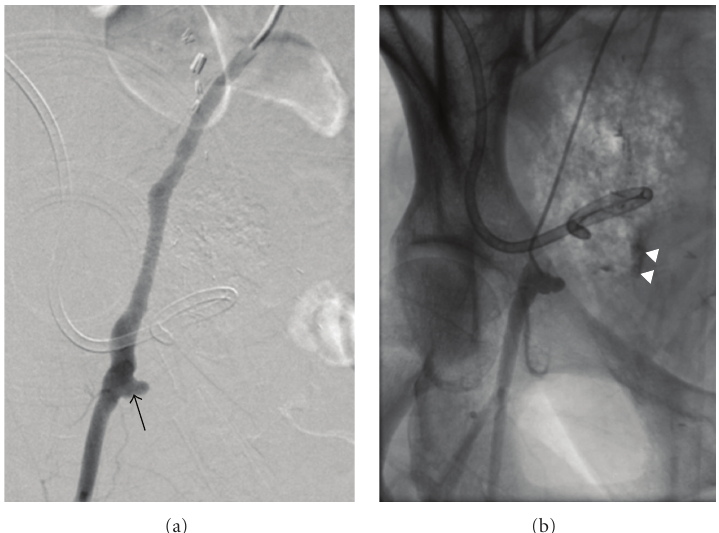
Figure 3: Digital subtraction (a) and unsubtracted (b) images from right iliac arteriogram reveal contrast extravasation (arrowheads) from right external iliac artery pseudoaneurysm (arrow).